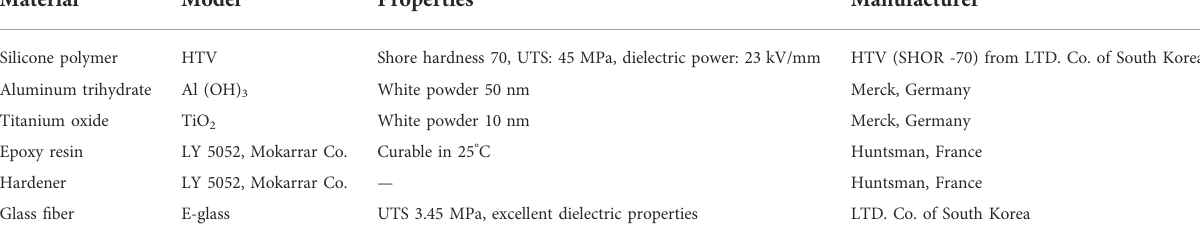
TABLE 1 Materials used for the preparation of the composite insulators.